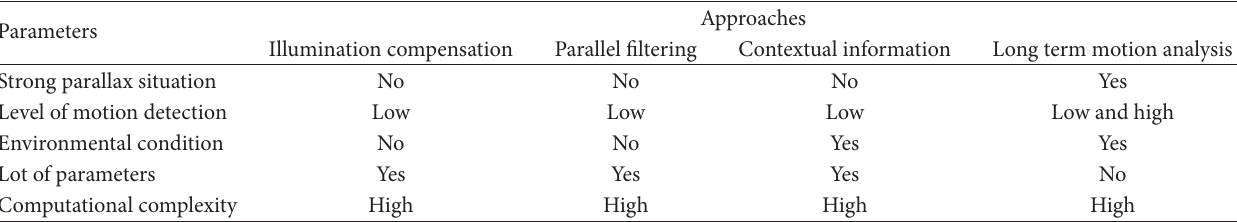
Figure 1: Existing approaches for motion based object detection. Table 1: Comparison of parameters for various motion analysis